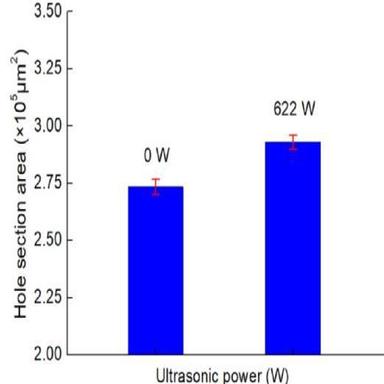
Comparison of semi-circular sections for the blind holes drilled using one laser pulse (a) without and (b) with water-based ultrasonic vibrations.